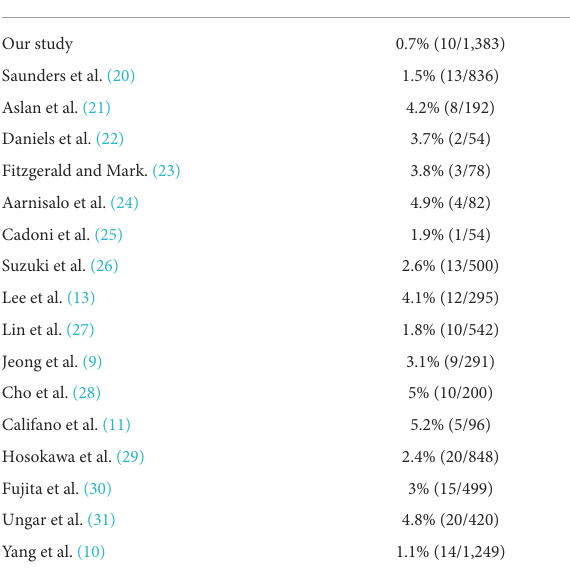
TABLE 3 Summary of studies where acoustic neuroma (AN) was detected in a sudden sensorineural hearing loss